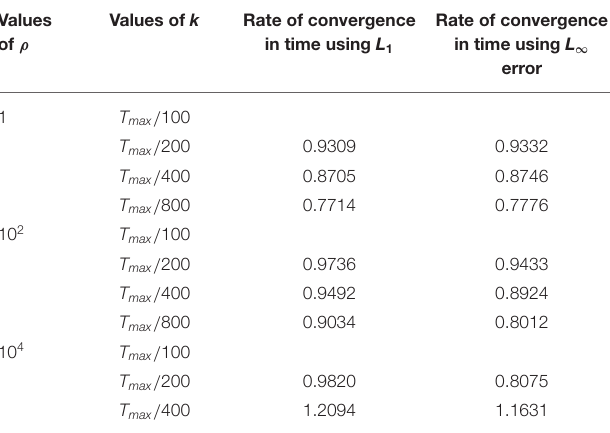
TABLE 4 | Rate of convergence in time for FTCS using different values of ρ at time, T max 2.5 10 − 3 with h 0.01. = × =